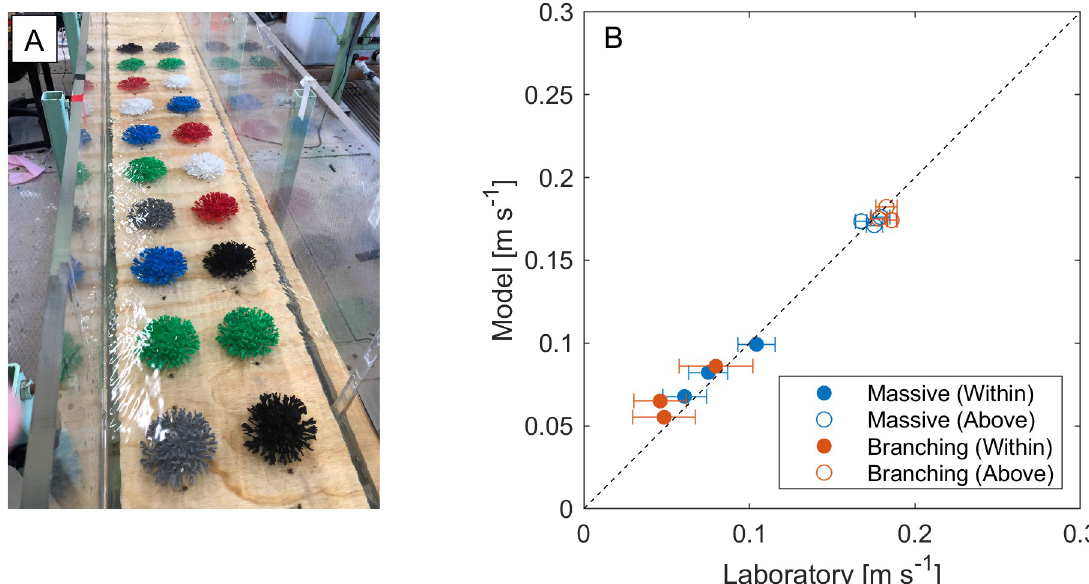
Fig 3. (A) Example of an experimental setup of the branching morphology used for directly measuring velocities in reefs comprised of 3-D printed coral specimens. (B) Comparison of within- and above-reef velocities predicted by the model with those observed in the laboratory. There is excellent agreement between model and experimental velocity values (RMSE =